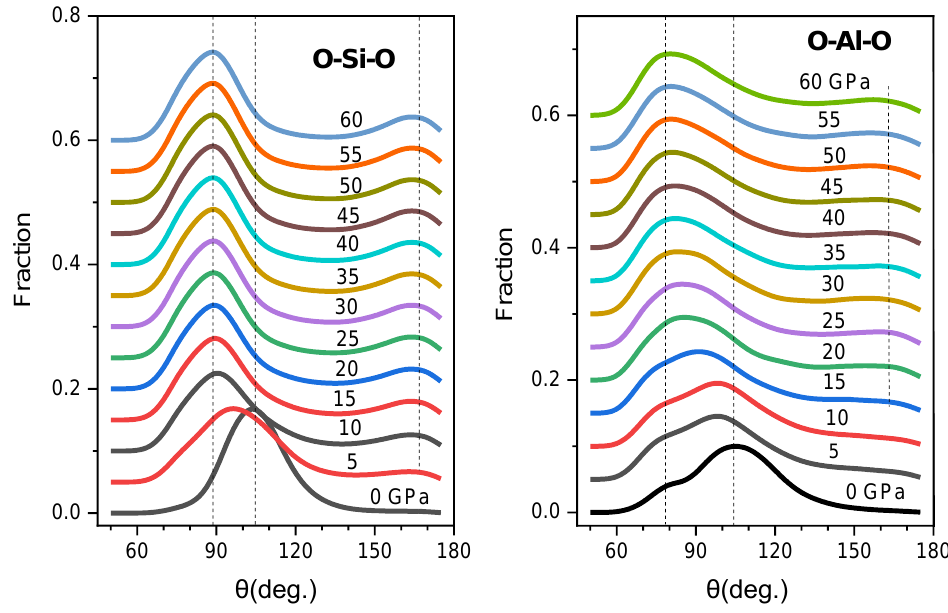
Figure 9. The total θ O─Si─O and θ O─Al─O bond angles distribution in AS2 model at different